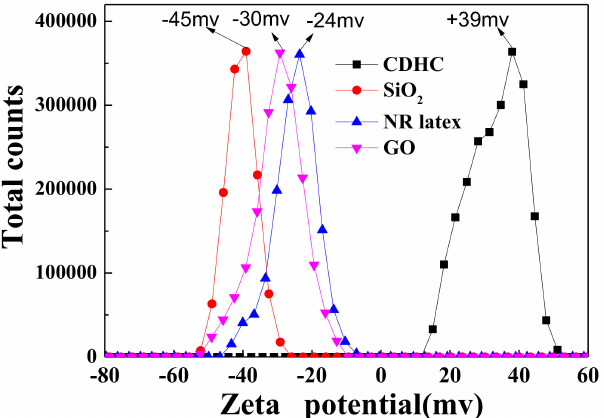
Figure 2. The zeta potential of GO, silica, NR latex, and cystamine dihydrochloride (CDHC)